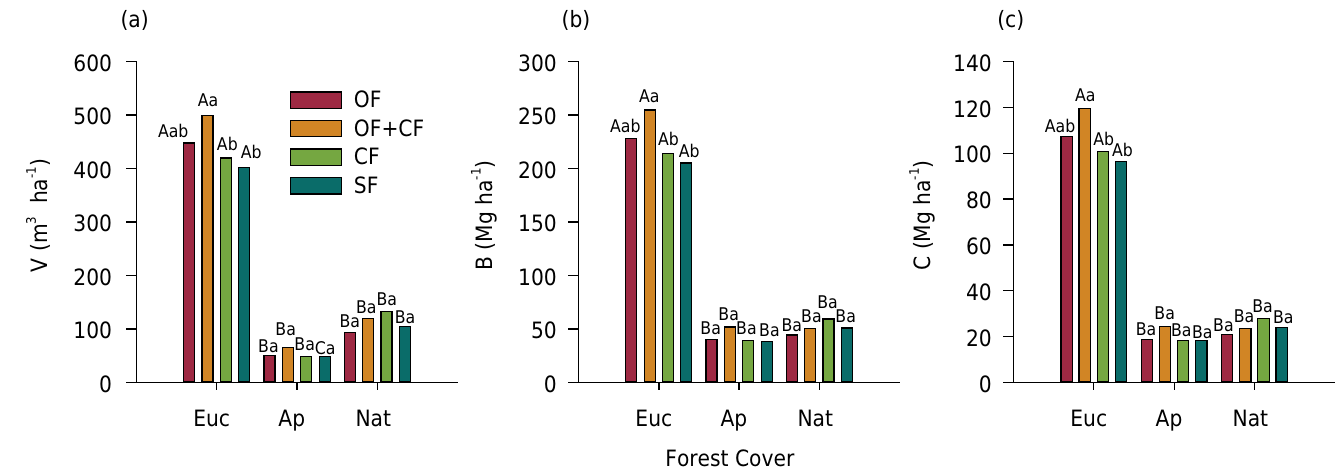
Figure 5. Volume with bark (a), biomass (b), and C stocks in the trunk with bark (c) for Eucalyptus (Euc), A. peregrina (Ap), and native species (Nat) at 56 months of age, planted in an area of bauxite mining and submitted to standard (SF), combined organic and chemical (OF+CF), organic (OF), and chemical (CF) fertilizers. Uppercase letters compare the mean values for the different forest covers, while lowercase letters compare the fertilization treatments within each type of cover and when equal, indicate the lack of significant difference between them by Tukey’s test at 10 % probability